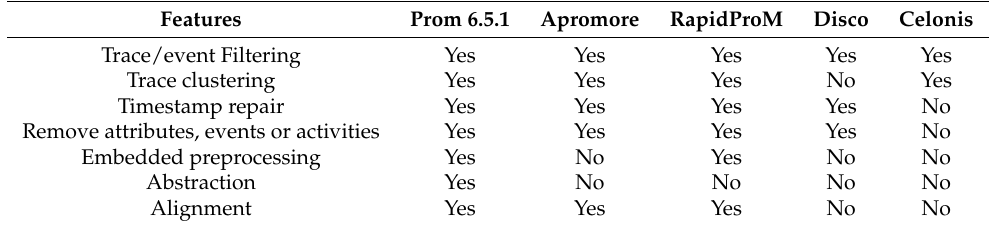
Table 5. Comparison of popular process mining tools incorporating event log preprocessing techniques.